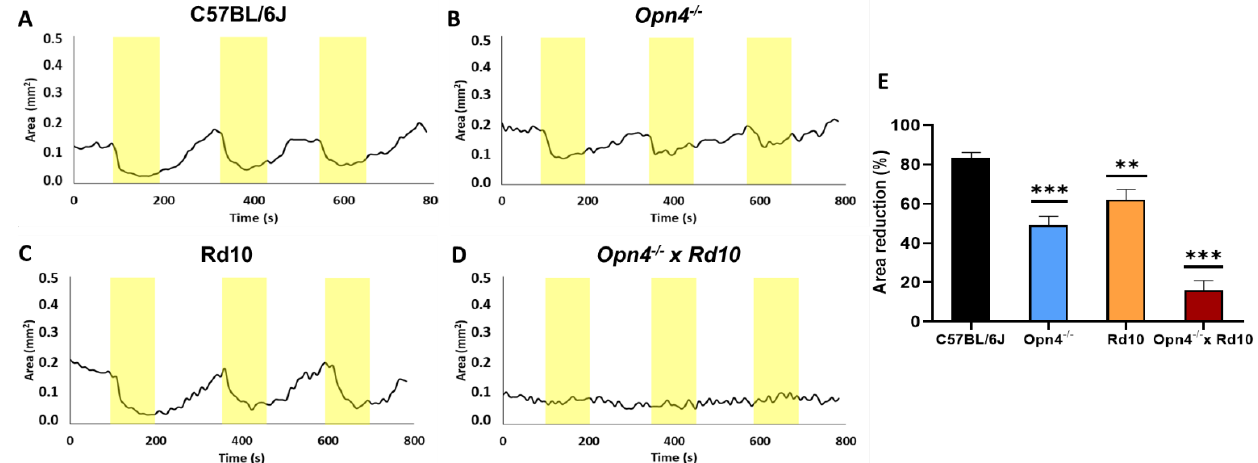
Figure 3. Variation of the pupillary area of the different animal models: C57BL/6J, ( A ); Opn4 −/− , ( B ); Rd10, ( C ); and Opn4 −/− × Rd10, ( D ), after a light stimulus. Representation of the percentage of pupillary contraction of the different animal models ( n = 8 for each group) when exposed to light stimuli (yellow stripes). The models with the mutation in the melanopsin gene ( Opn4 −/− ), showed a significant decrease in the pupillary contraction capacity ( E ). The double mutant animals did not show any sign of pupillary contraction when exposed to light stimuli. The area was measured in mm 2 . Data are presented as mean ± SEM, (**, p < 0.005; ***, p < 0.001).